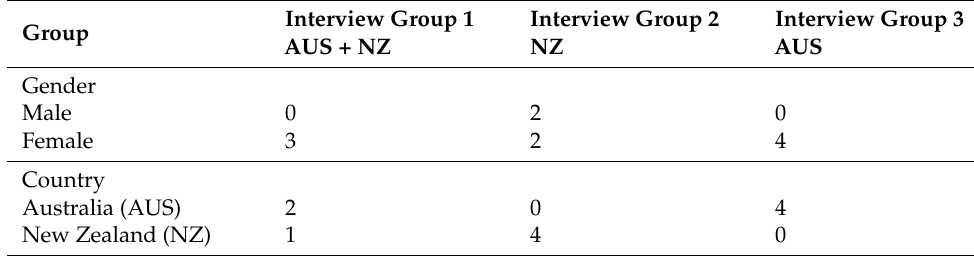
Table 1. Interview group